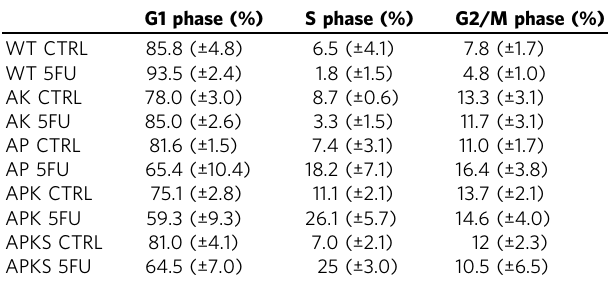
Table 1 Cell cycle phases analyzed by fl ow cytometry in WT and CRC organoids treated with 5-FU for 48